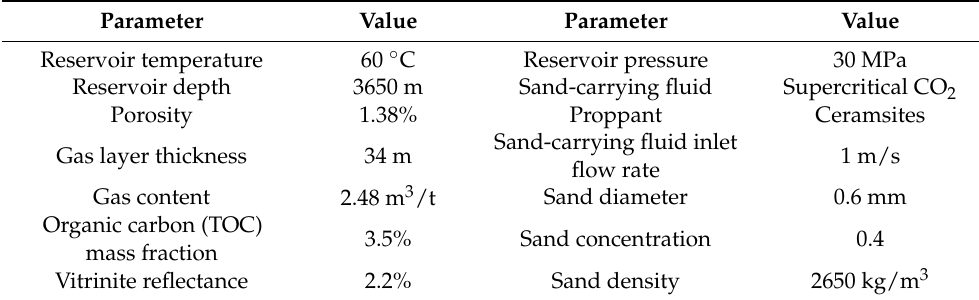
Table 2. Basic parameters of shale gas reservoir.